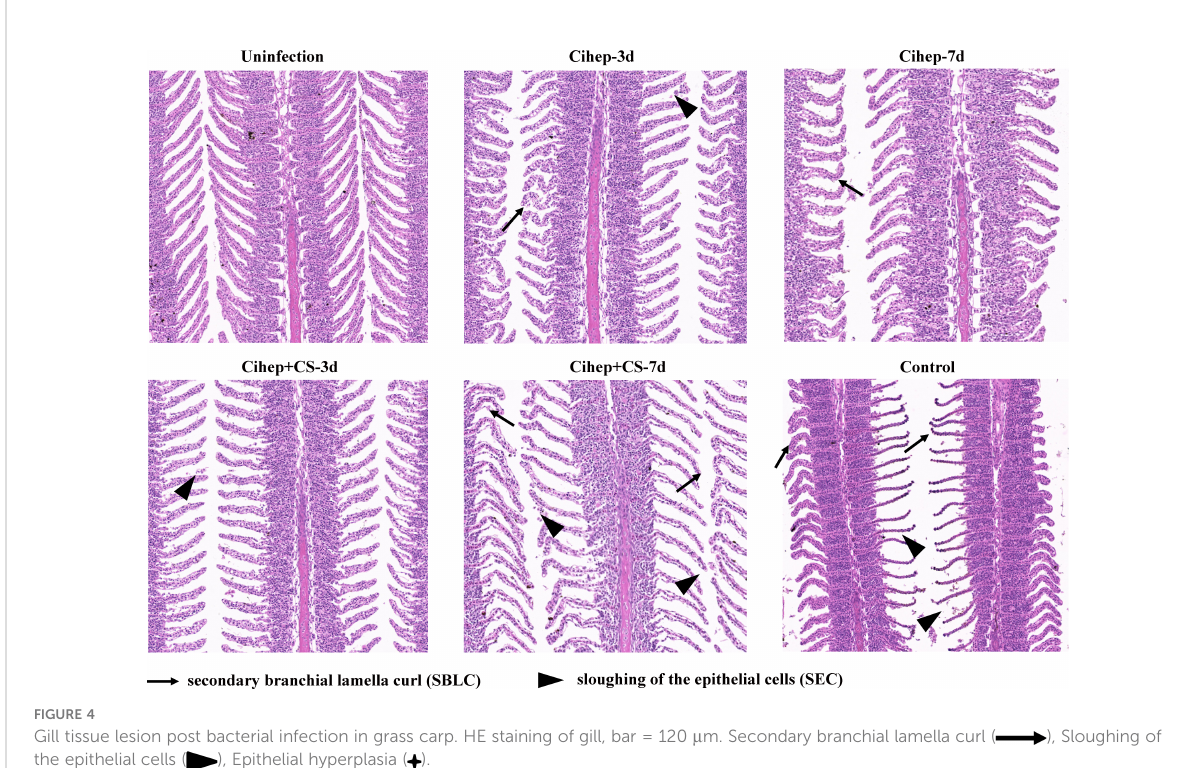
FIGURE 4 Gill tissue lesion post bacterial infection in grass carp. HE staining of gill, bar = 120 m m. Secondary branchial lamella curl ( ), Epithelial hyperplasia (